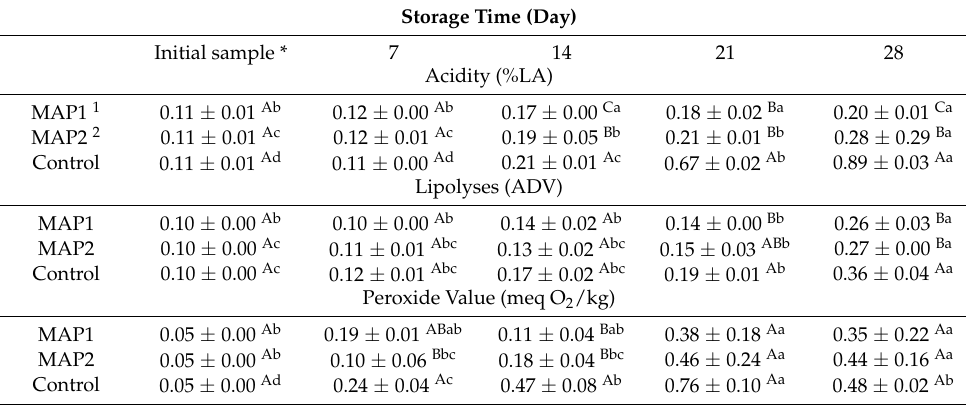
Table 4. The biochemical analysis results of CC